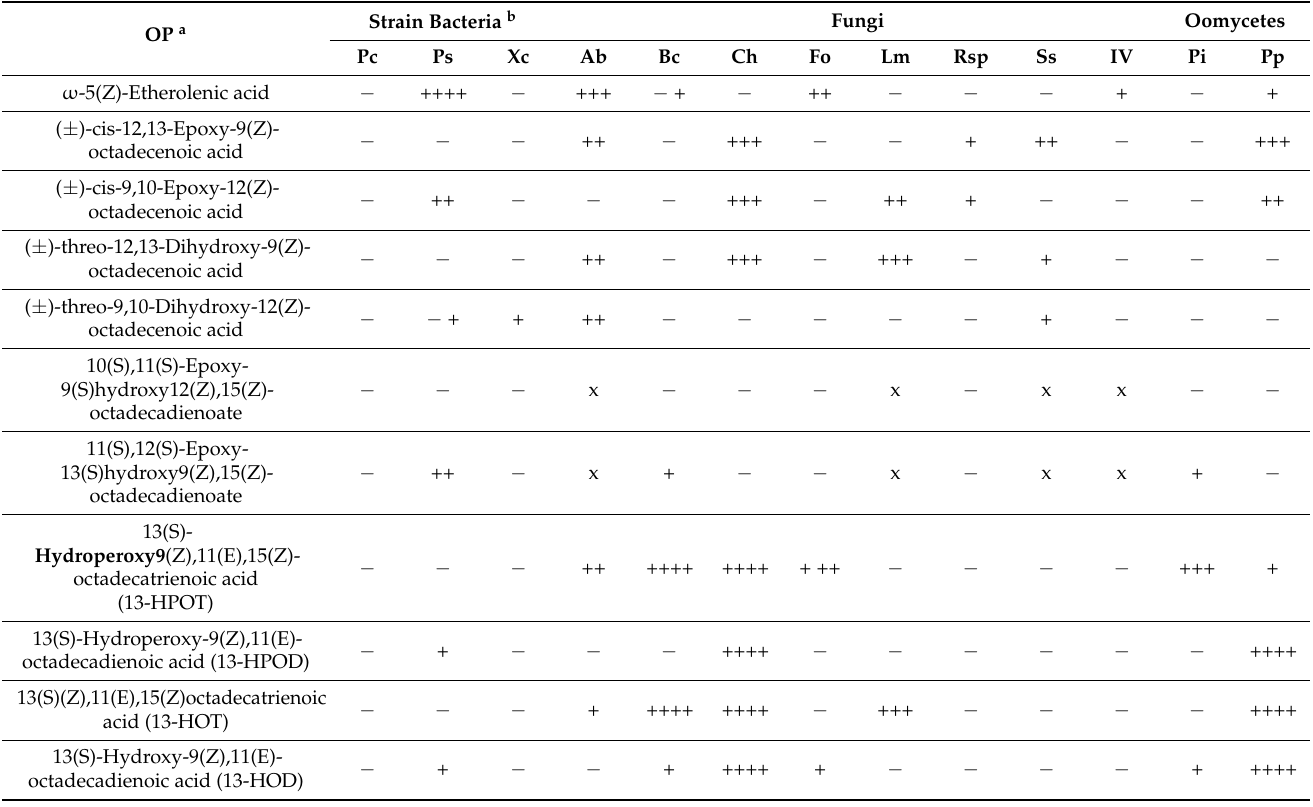
Table 2. List of effective non-antimicrobial OPs in in vitro